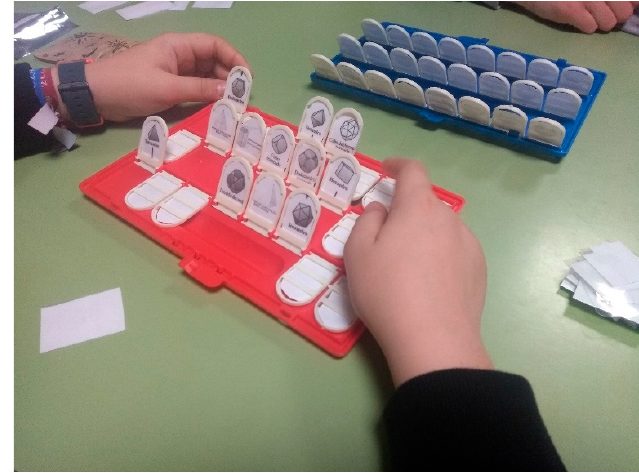
Figure 9. Polyhedral game “who’s who”. Own elaboration.